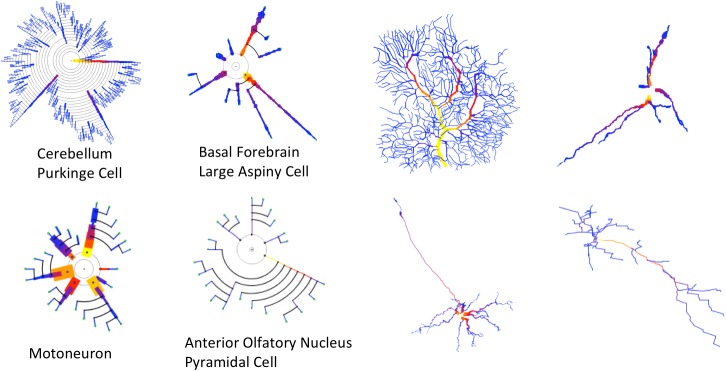
Four cells with very different morphologies, presenting their dendrograms (left) and morphological tracings (right). The symbolic model preserves (and even emphasizes) morphological variations among cells. Line width and color provide increased information in the dendrograms. Purkinje Cell: Guinea pig, Cerebellum. NeuroMorpho.Org ID NMO_00610 (Rapp et al., 1994). Large Aspiny Cell: rat, ventral striatum. NeuroMorpho.Org ID NMO_04423 (McDonald et al., 2007). Motoneuron: rat, brainstem. NeuroMorpho.Org ID NMO_00665 (Nüñez-Abades et al., 1994). Anterior Olfactory Nucleus: rat, anterior olfactory nucleus. NeuroMorpho.Org ID NMO_05982 (Brunjes and Kenerson, 2009).